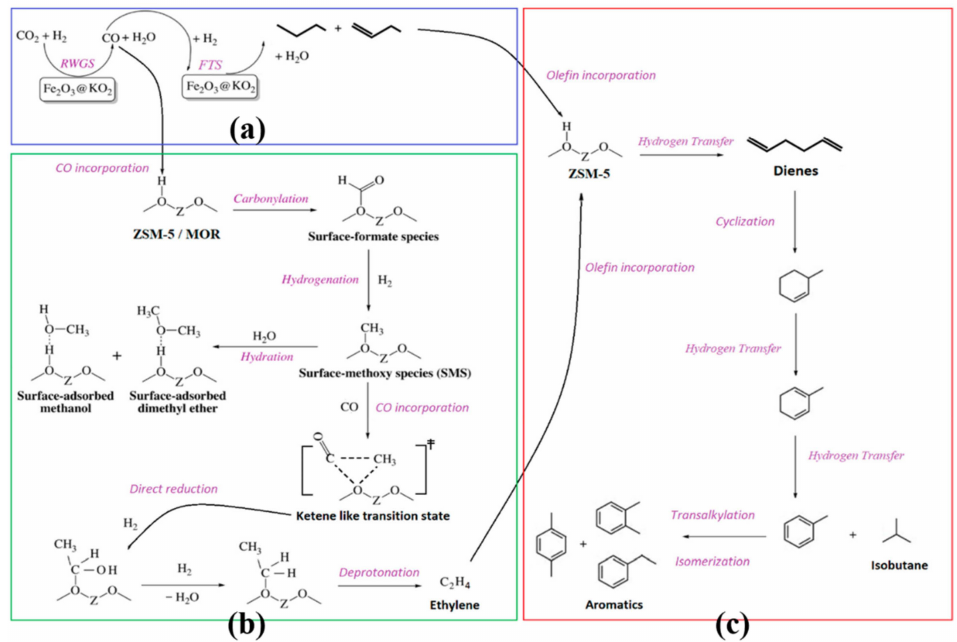
Figure 22. Proposed reaction pathways of Fe 2 O 3 @KO 2 /zeolite catalyst hydrogenation of CO 2 to light olefins and aromatics. ( a ) CO 2 hydrogenation pathway on the stand-alone Fe 2 O 3 @KO 2 catalysts. ( b ) CO incorporation pathway on HZSM-5. ( c ) Aromatization pathway on HZSM-5. Reprinted with permission from Ramirez et al. [118]. Copyright (2019) American Chemical